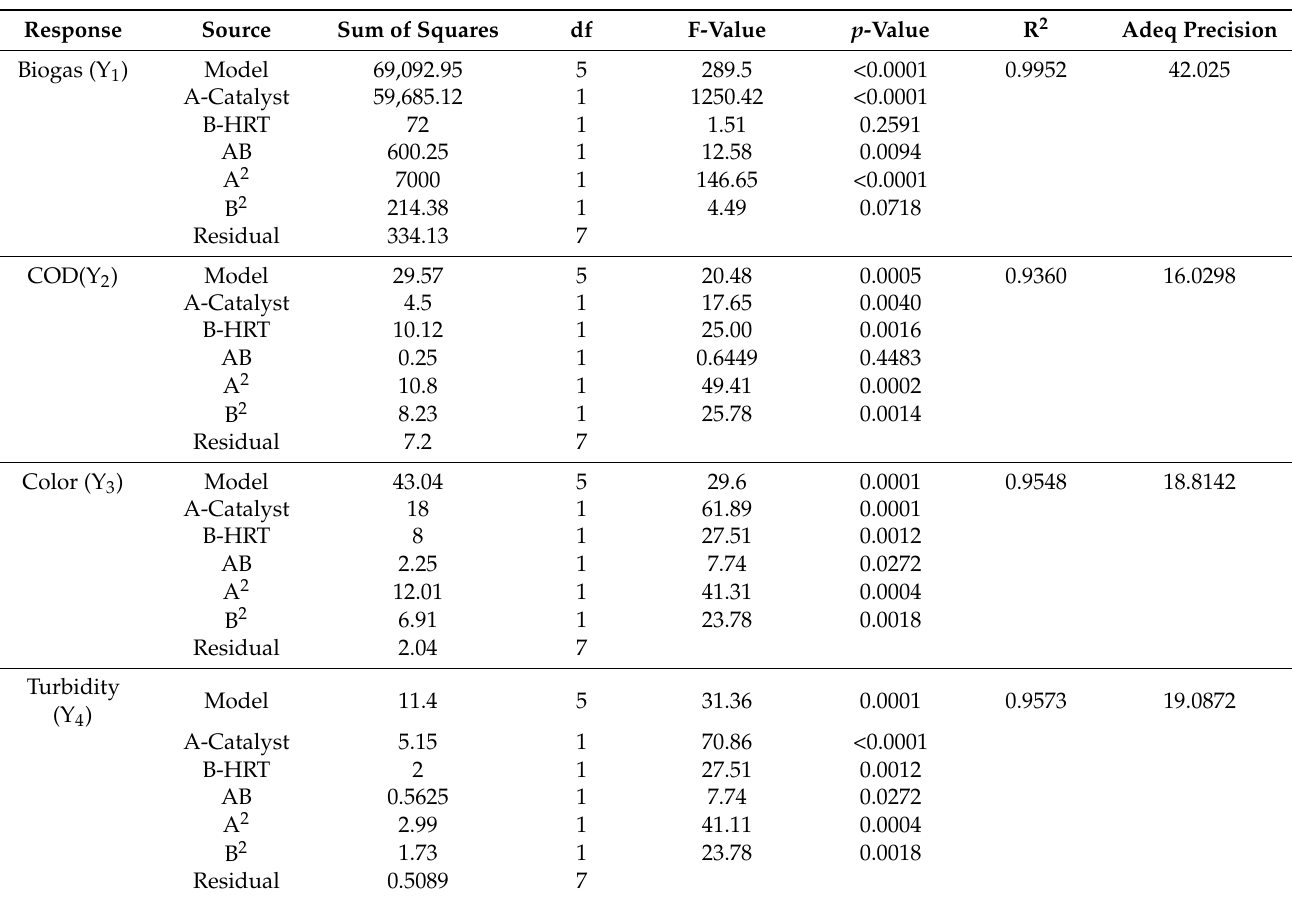
Table 4. A modified RSM-BBD. model analysis of variance